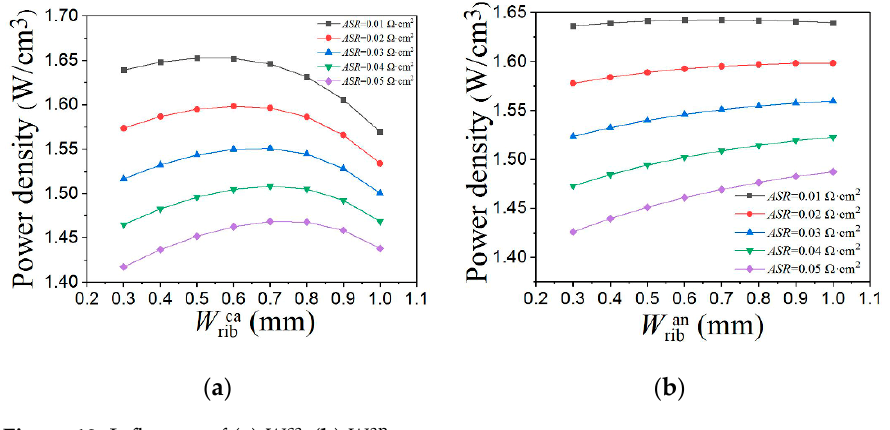
Figure 10 . Influence of ( a ) ( b ) . Figure 10. Influence of ( a ) W ca